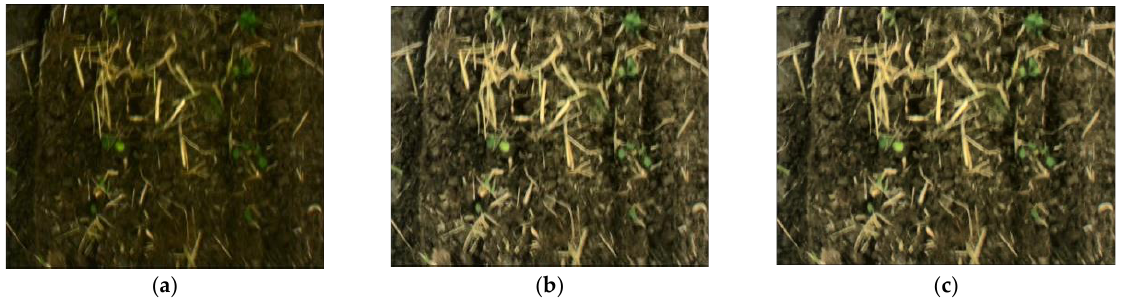
Figure 3. Comparison of image equalization and filtering. ( a ) Original image, ( b ) CLAHE processed image, ( c ) Bilateral filter map.